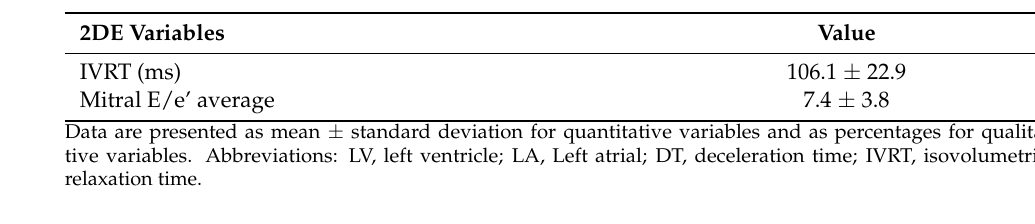
Table 3. Two-dimensional echocardiographic (2DE) parameters of the right ventricular structure and function in the study population.